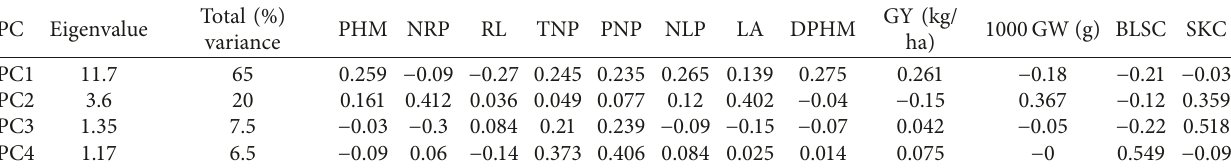
Table 8: Principal components analysis of agro-morphological traits of